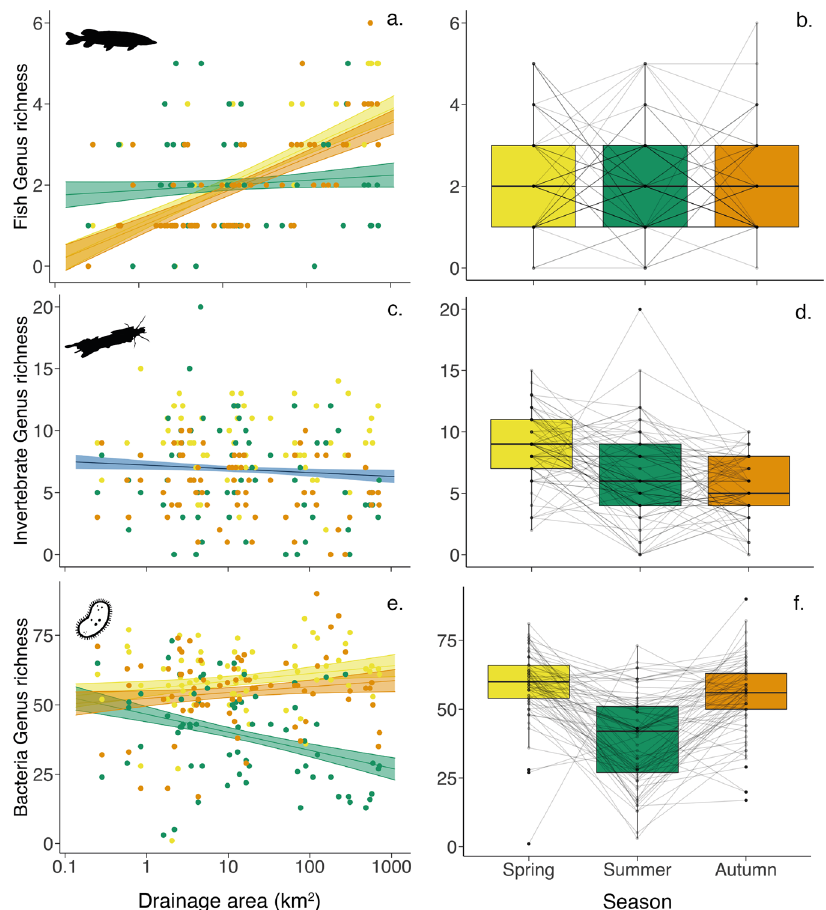
Fig. 3 Genus α -diversity in space and time. Plots ( a ), ( c ) and ( e ) show α -diversity in each group as a function of drainage area. Lines indicate linear mixed- effects models with shaded area showing 95% con fi dence intervals as calculated using the model predictions and standard error. Plots ( a ) and ( e ) show the models with a signi fi cant interaction between drainage area and season with the difference across each season (colour represents season). Plot ( c ) shows no signi fi cant effect of this interaction, the line indicates the model output of all data as a function of drainage area which is not signi fi cant (blue). Plots ( b ), ( d ) and ( f ) show change in α -diversity in each group over season with samples sites linked by grey lines over the three sampling seasons. Colour represents season: yellow — Spring, green — Summer and orange —